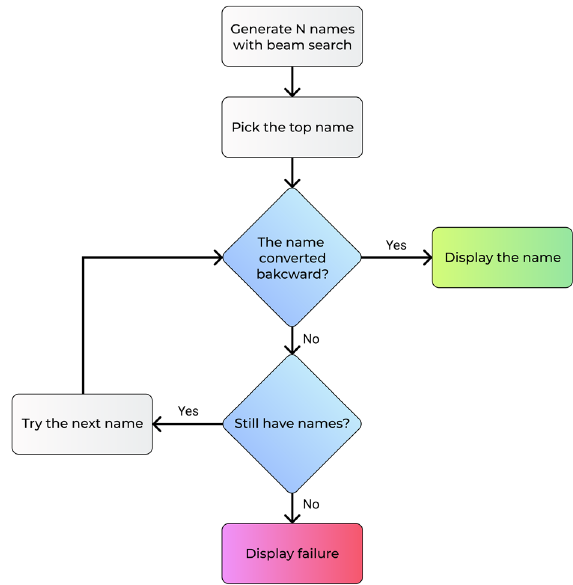
Figure 3. A scheme of Verification step.